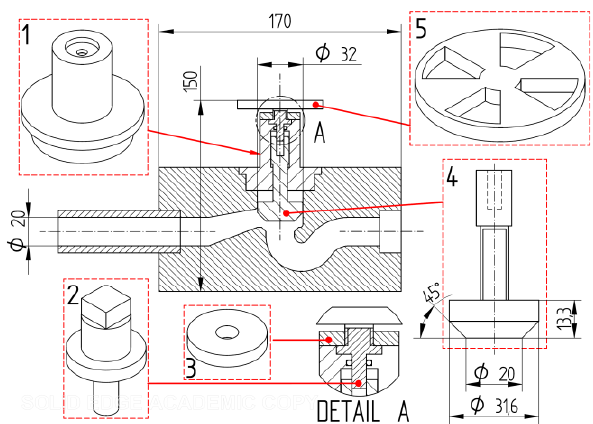
Fig. 3. Caption of the Figure 1. Below the figure .